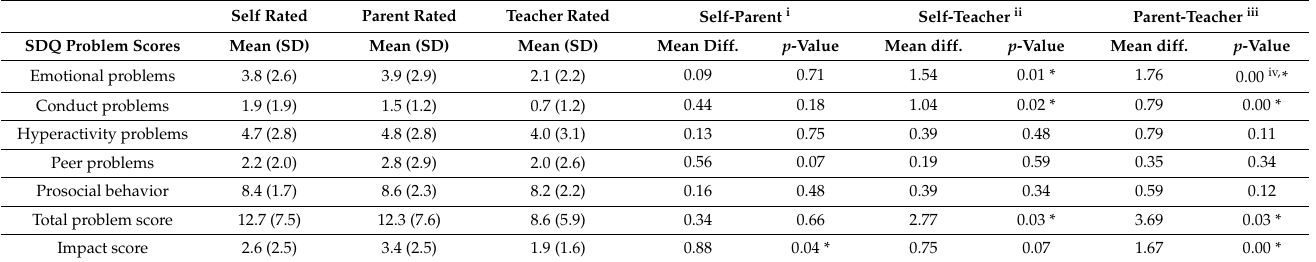
Table 3. Mean scores and mean differences between self, parent and teacher ratings of SDQ at age 11 for children with Cerebral Palsy (n = 36).